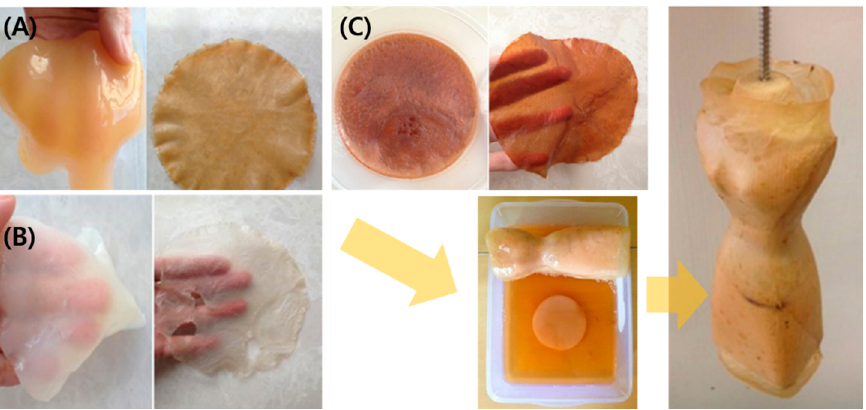
Figure 13. The cellulosic pellicles grown from the selected types of BC ( A ) beer, ( B ) milk, and ( C ) wine. Reprinted with permission from [187]. Copyright 2016 Taylor & Francis.